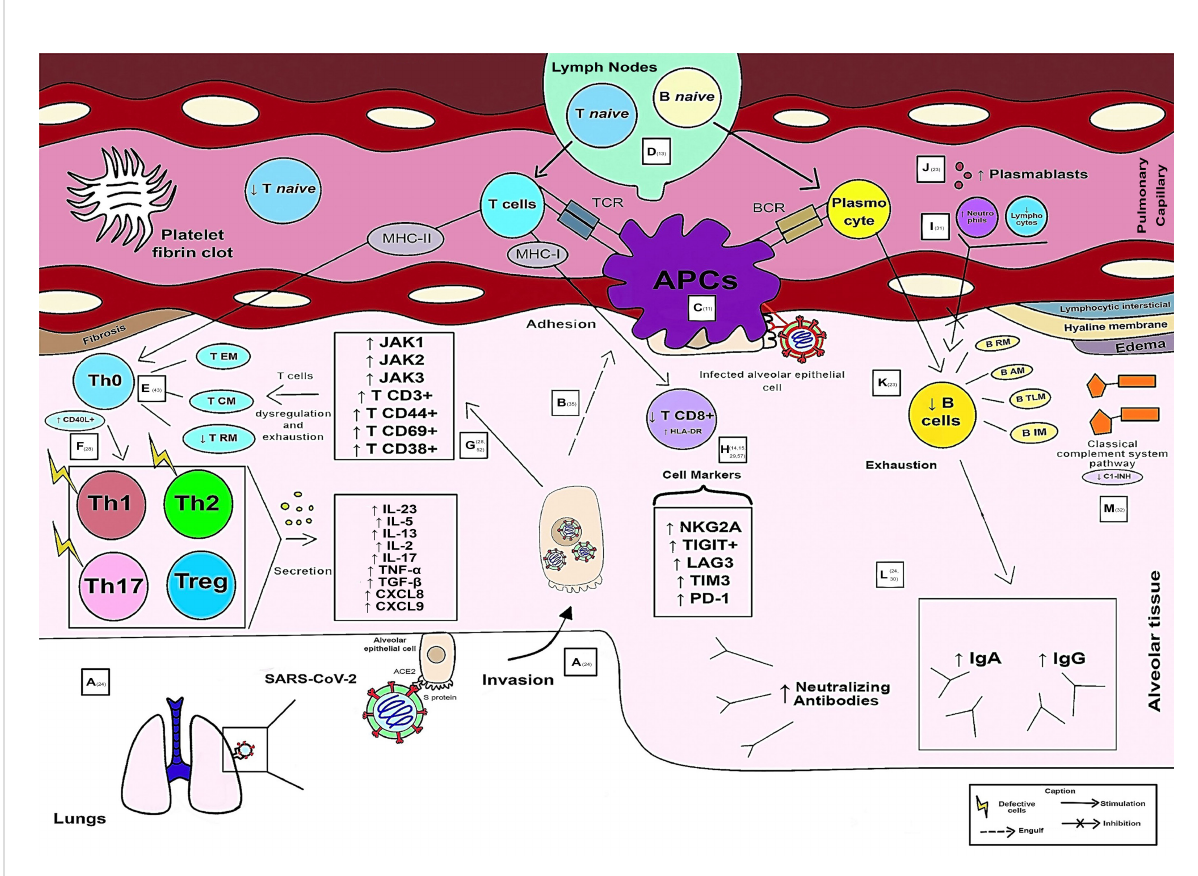
FIGURE 3 Schematic model of the evolution of the Adaptive Immune Response in severe and critical cases of